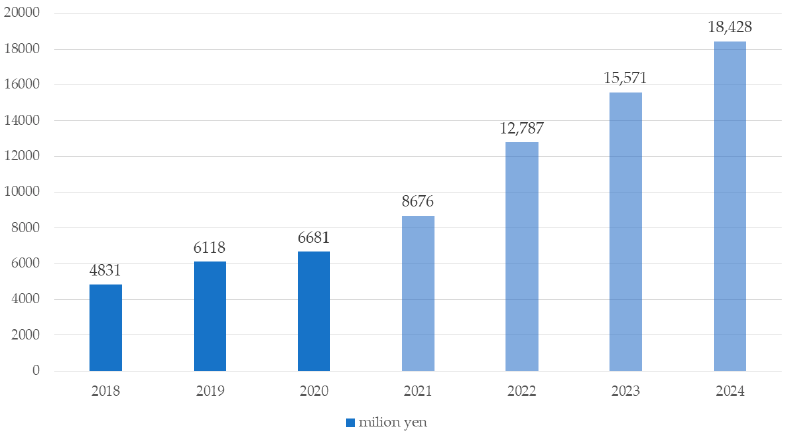
Figure 1. Domestic Esports market in